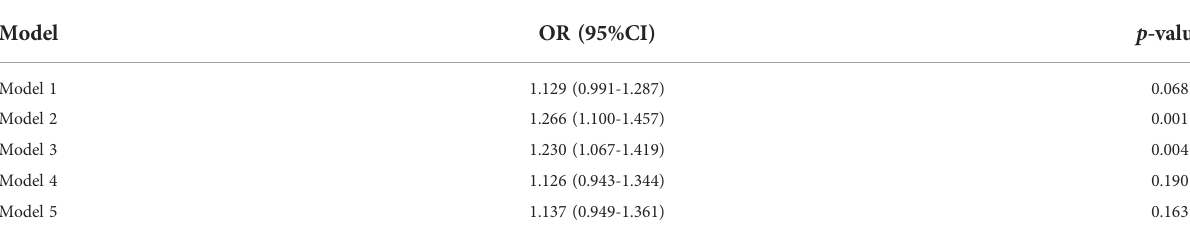
TABLE 3 Multivariate logistic regression analysis of sex for